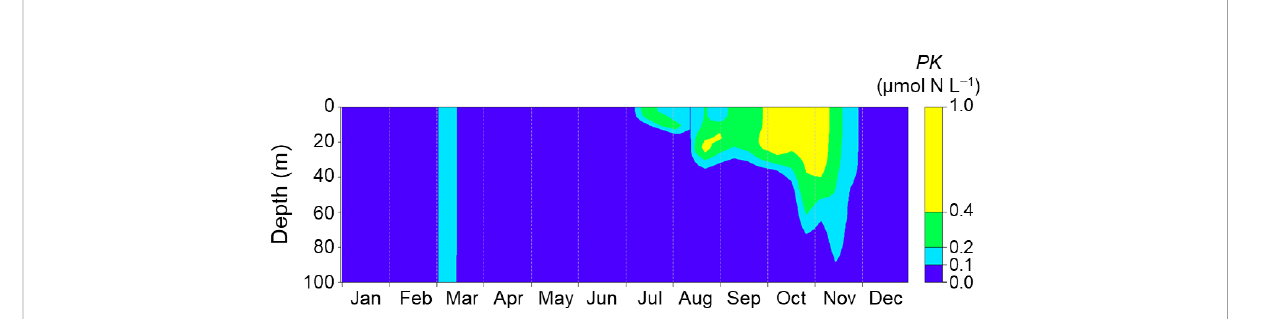
FIGURE 5 Seasonal changes of PK concentration simulated with the daily mean of driving forces at Stn. A1 in 2021. The biomass was initialized on day